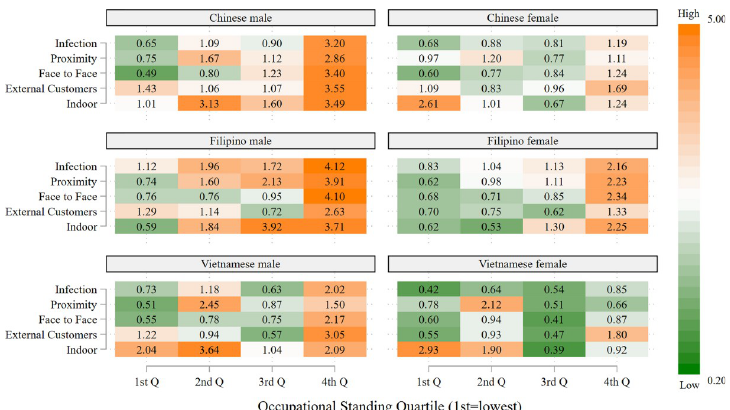
Fig 3. Representation of frontline workers in high-risk occupations relative to representation as frontline workers by occupational standing: Chinese, Filipino, and Vietnamese workers, by sex. Data are from the 2018 American Community Survey (ACS). Occupations are considered to be high-risk if the average value for the risk factor in the O � NET data falls in the highest quartile of the occupations in the analysis. Occupational standing (OS) is defined as the percentage of ACS respondents reporting this occupation who completed at least one year of college education. The 1 st OS quartile is the lowest and the 4 th OS quartile the highest. https://doi.org/10.1371/journal.pone.0256085.g003 indicators. In general, the overrepresentation of men in high-risk jobs with high OS exceeds that for women in these ethnic groups. As shown in the top two panels of Fig 4, a similar pat- tern occurs for Korean and other Asian workers, i.e., large overrepresentation, especially for men, in high-risk, high OS occupations. The majority of Filipino men and women, and Chi- nese and Korean women, who are in high OS frontline occupations are registered nurses. The other frequently held occupations for these groups are also in the healthcare sector. Chinese and Korean men with the highest OS frontline occupations are most likely to be physicians and surgeons, but are also employed as dentists, pharmacists and registered nurses. The high proportion of Asians in the healthcare sector largely accounts for their disproportionate